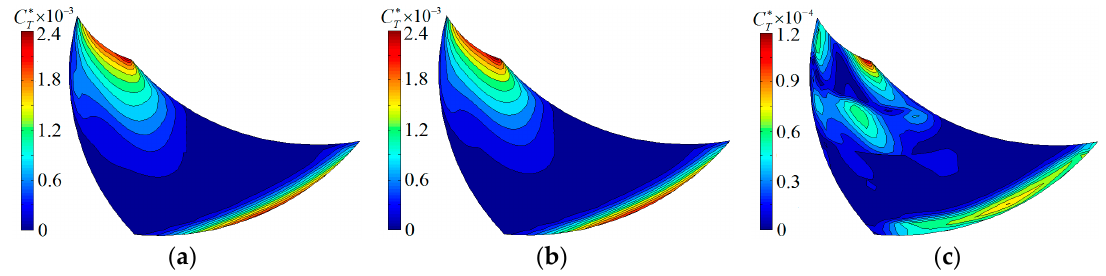
Figure 14. CFD calculation, POD reconstruction and their error of turbulent kinetic energy fluctuation intensity on the single channel plane. ( a ) POD reconstruction; ( b ) CFD calculation; ( c ) Error.